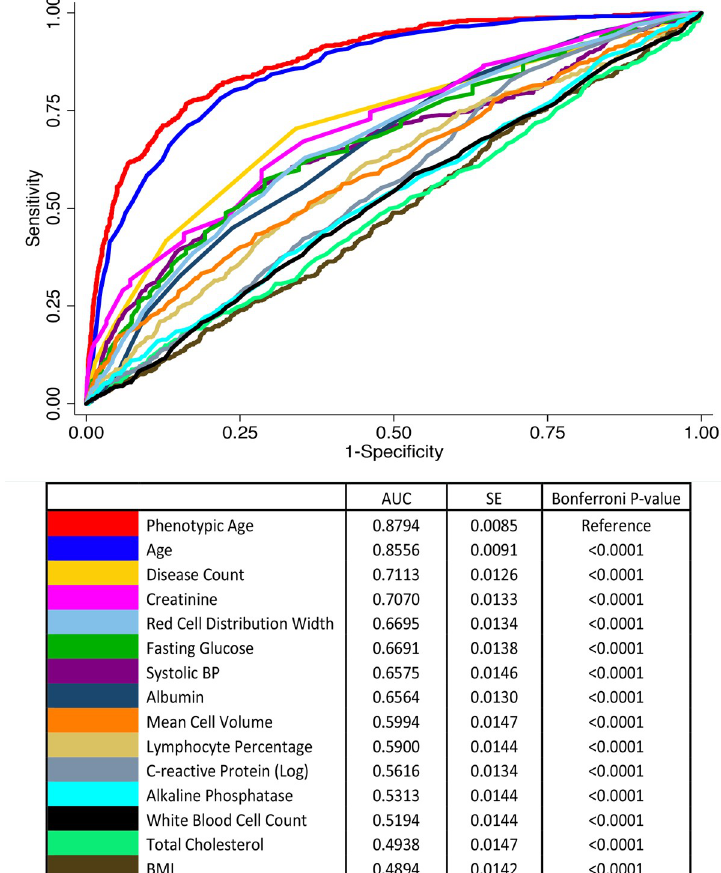
Fig 7. Receiver operating characteristic curves for 10-year mortality. AUC, area under the curve; BMI, body mass index; BP, blood pressure; SE, standard error.